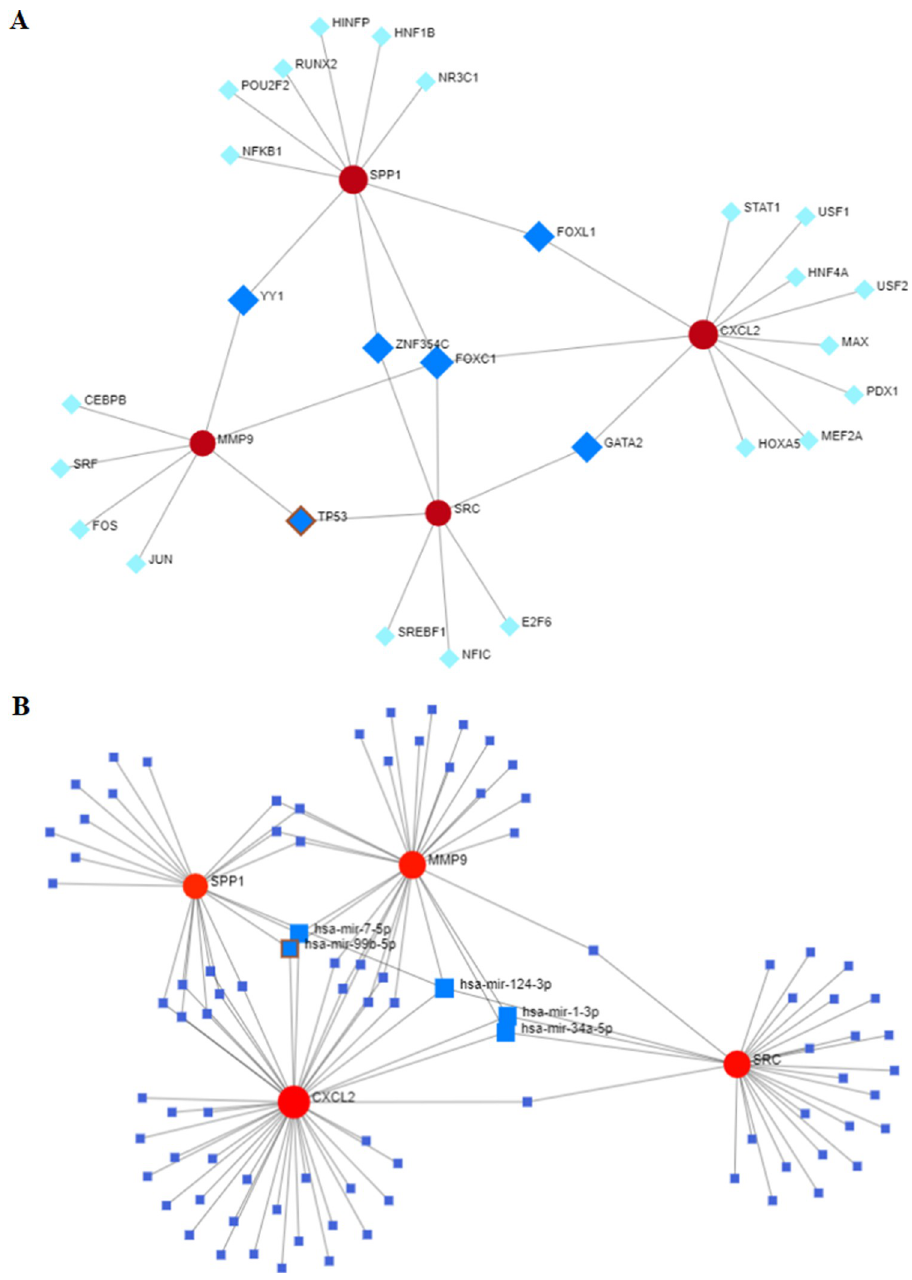
Fig 8. Hub gene interaction network. (A) Hub genes—transcription factors (TFs): The red spheres represent four hub genes; the blue squares represent six major hub genes-associated TFs and the cyan squares represent other gene- associated TFs; (B) Hub genes—miRNAs: red spheres represent four hub genes; the bigger blue squares show five main hub gene-associated miRNAs; the smaller blue squares show other hub gene-associated miRNAs.